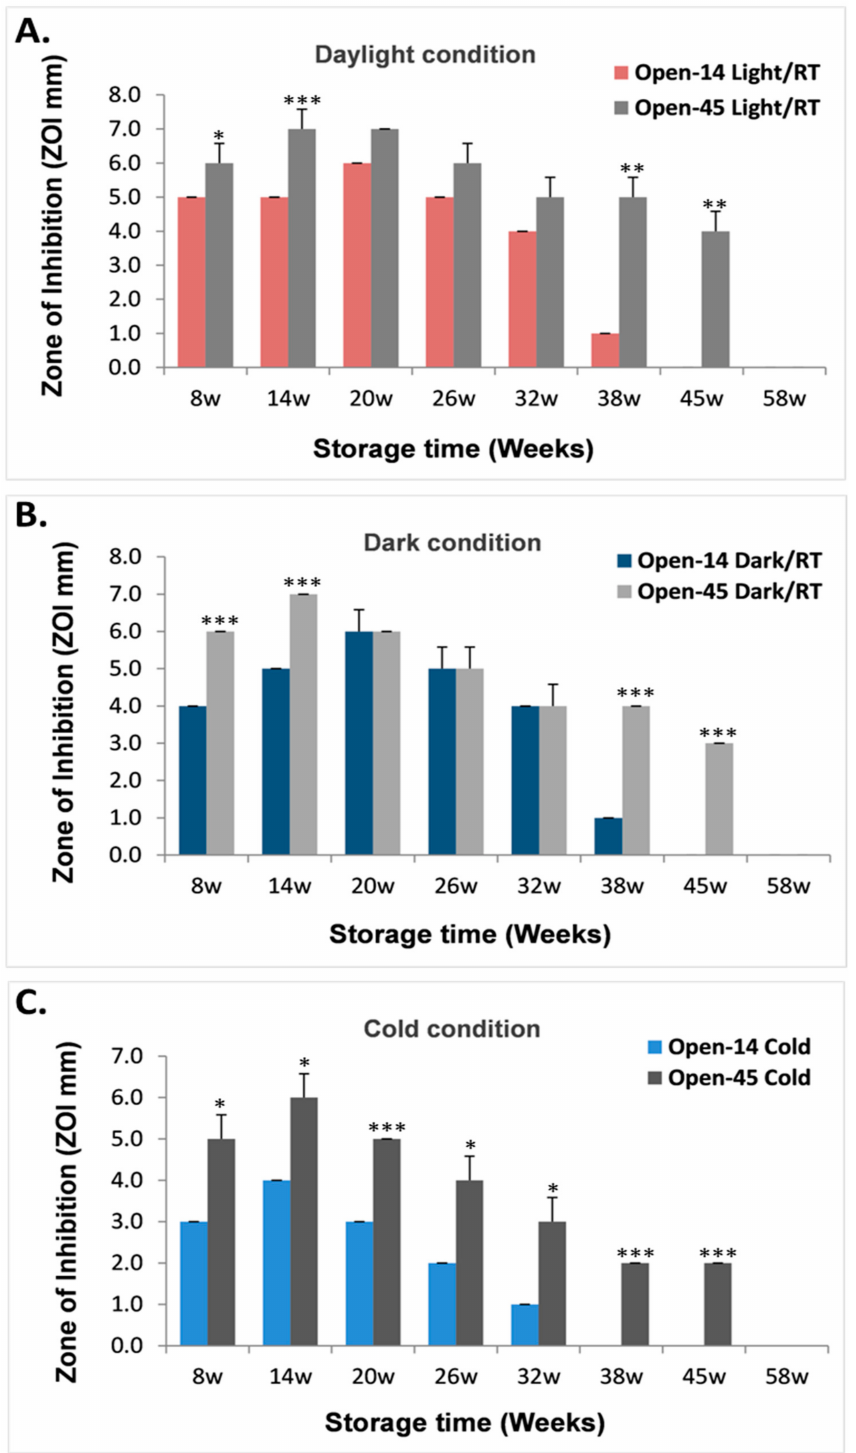
Figure 3. The effect of frequent air exposure of laser generated AgNPs on its antibacterial activities under different storage conditions. The laser generated AgNPs were stored under three different conditions: daylight ( A ) and dark ( B ) at room temperature (RT) and cold at 4 ◦ C ( C ). The antibacterial effects of AgNPs were determined every 14 days (Open-14) or every 45 days (Open-45) using the well-diffusion method, and results were presented when the tests were conducted in the same week. Data are mean ± SE. * p ≤ 0.05, ** p ≤ 0.01, *** p ≤ 0.001, n =